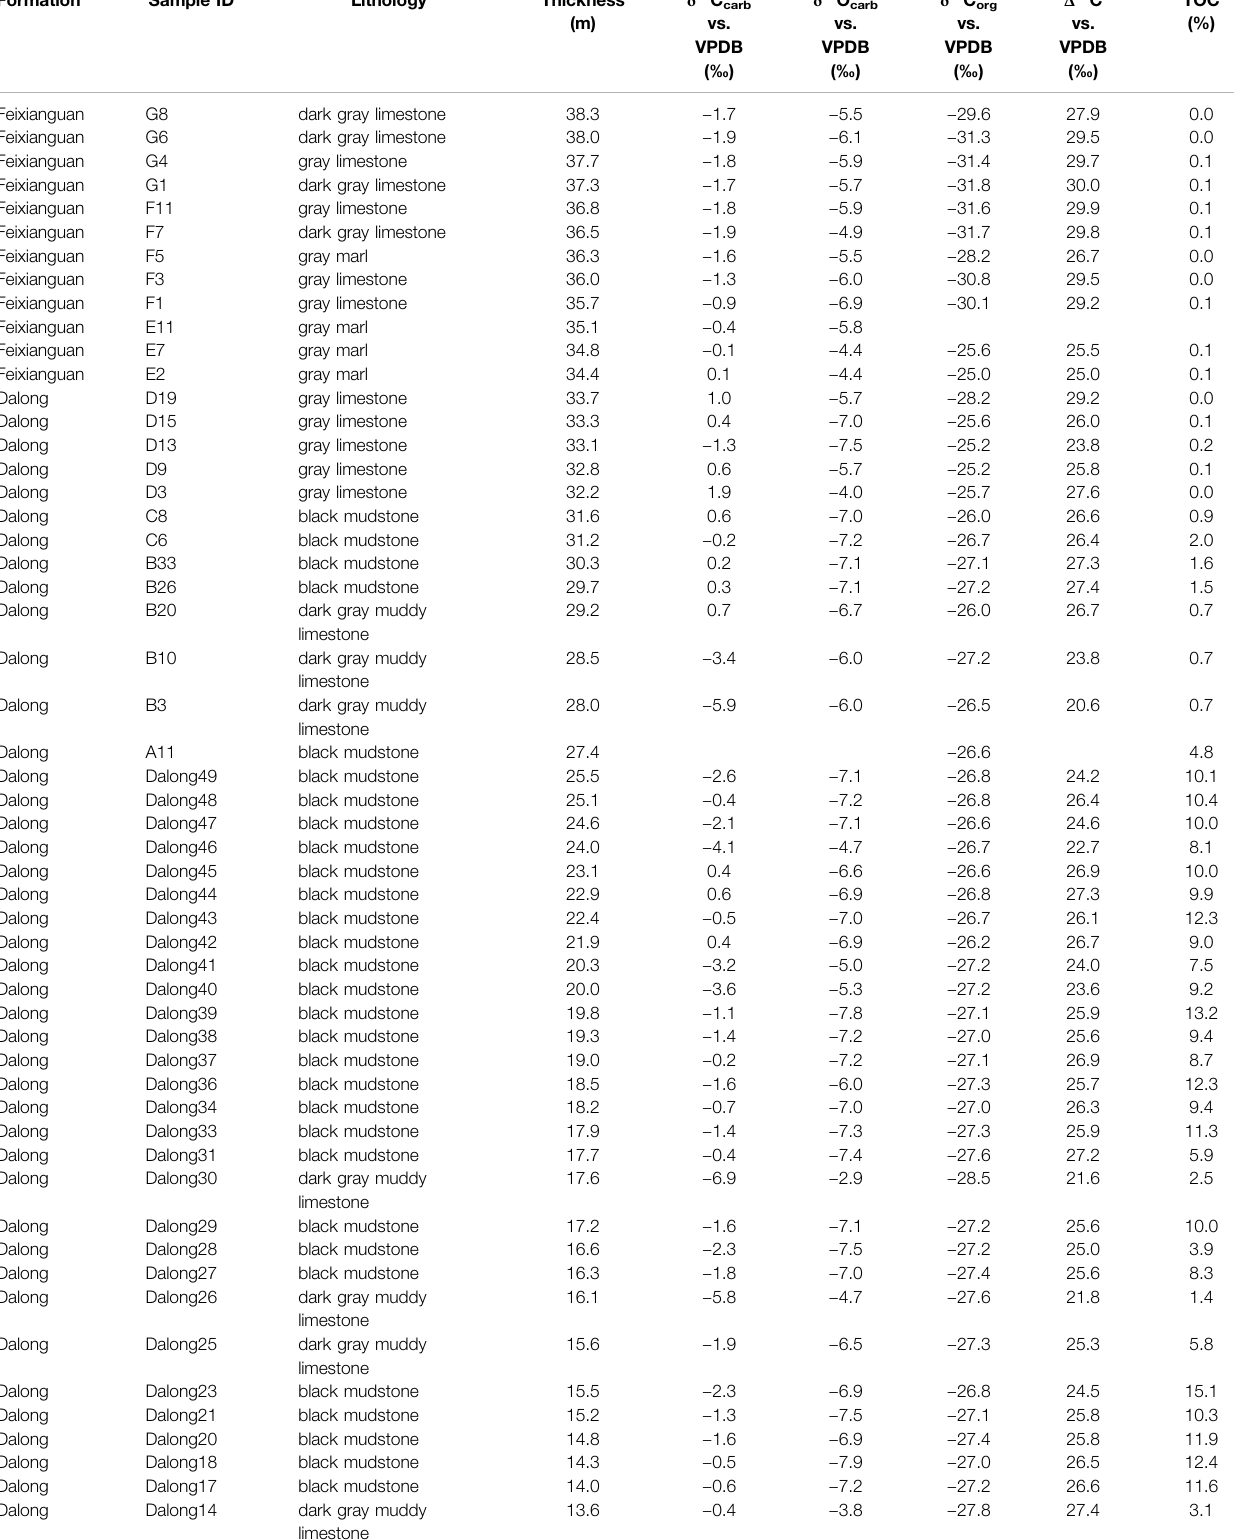
TABLE 1 | C and O isotopic composition of the analyzed P-TB interval at Chaotian. The δ 13 C org values and TOC contents were reported in Saitoh et al. (2014a).